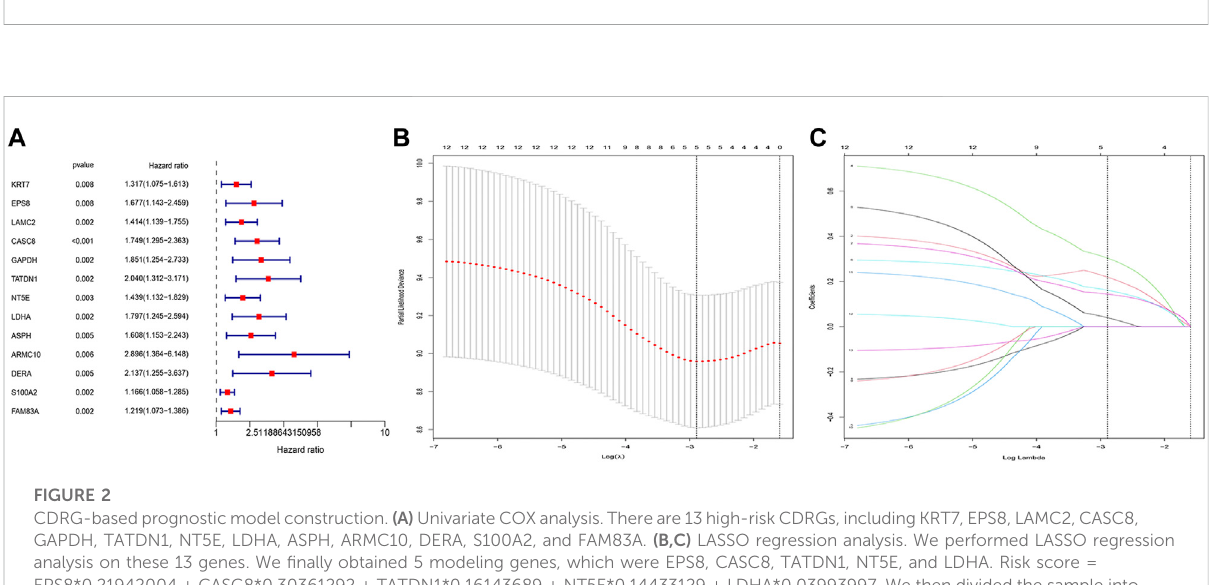
FIGURE 1 Single-cell sequencing analysis. (A) Integration and cluster analysis. We can fi nd the distribution of these 14 clusters (B) Distribution of low- copper-dependent cells and high-copper-dependent cells. We found that the distribution of low_cuproptosis cells and high_cuproptosis cells in each cell cluster was relatively uniform. (C) WGCNA showed MEgrey was linked to the survival status.